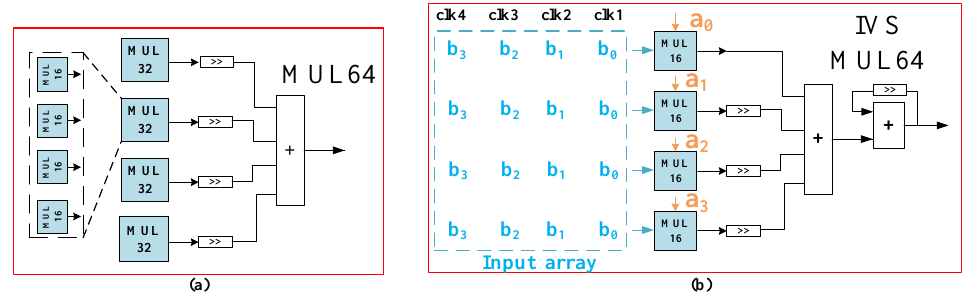
Figure 1. ( a ) The structure of a full-parallel 64-bit multiplier in [18]; ( b ) The IVS structure of the proposed 64-bit